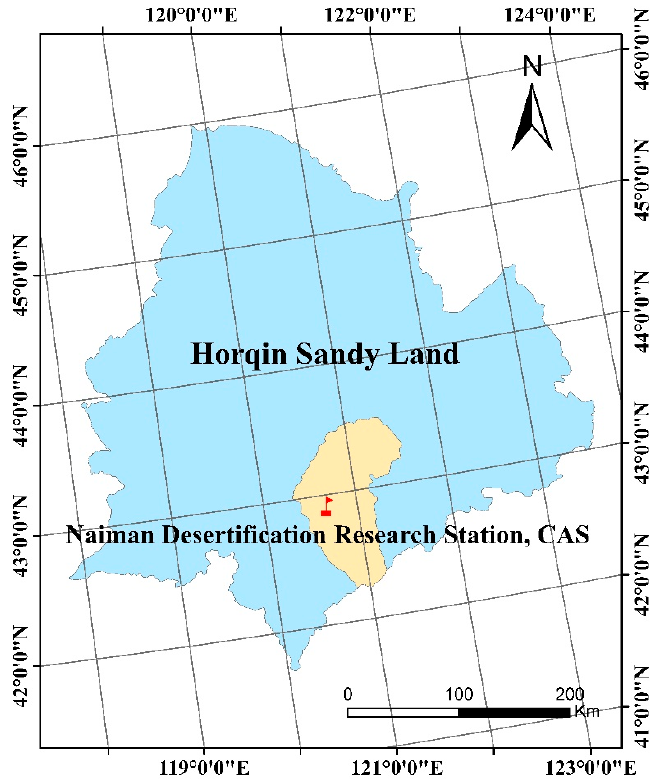
Figure 1. Location of Naiman desertification research station in China. Notes: the blue region represents Horqin Sandy Land; the yellow region represents the Naiman banner; the red flag represents Naiman desertification research station, CAS.